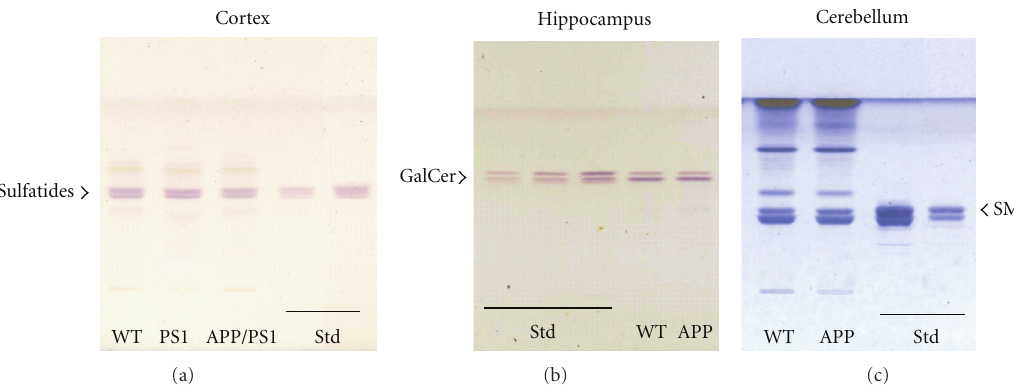
Figure 4: Examples of HPTLC profiles of sphingolipids from di ff erent brain regions of nontransgenic and transgenic mice. (a) Sulfatides from cerebral cortex of 12-month-old APP SL /PS1 M146L , PS1 M146L , and their age-matched wild-type (WT) control mice. (b) Galactosylceramides (GalCer) from hippocampus of 24-month-old APP SL mice and age-matched WT control mice. Galcer and sulfatides were developed in chloroform-methanol-water (65:25 :4), sprayed with orcinol-H 2 SO 4 reagent, and then heated. Both Galcer and sulfatides ∗ appear as two bands corresponding to the 2-HFA- (lower band) and NFA-containing galactolipids (upper band), respectively. ∗ Standard sulfatides from bovine brain resolved in three bands, as a result of di ff erent fatty acid chain length. (c) Sphingomyelins (SM) from cerebellum of 24-month-old APP SL mice and age-matched WT control mice; SMs were developed with chloroform-methanol-water (60:35: 8) (v/v/v) and visualized with sulfuric acid –CuSO 4 -ammonium molybdate spray reagent followed by heating. SMs appear as two bands which result of the di ff erences in the fatty acid chain length. Std: standard sulfatides, GalCer, and SM,